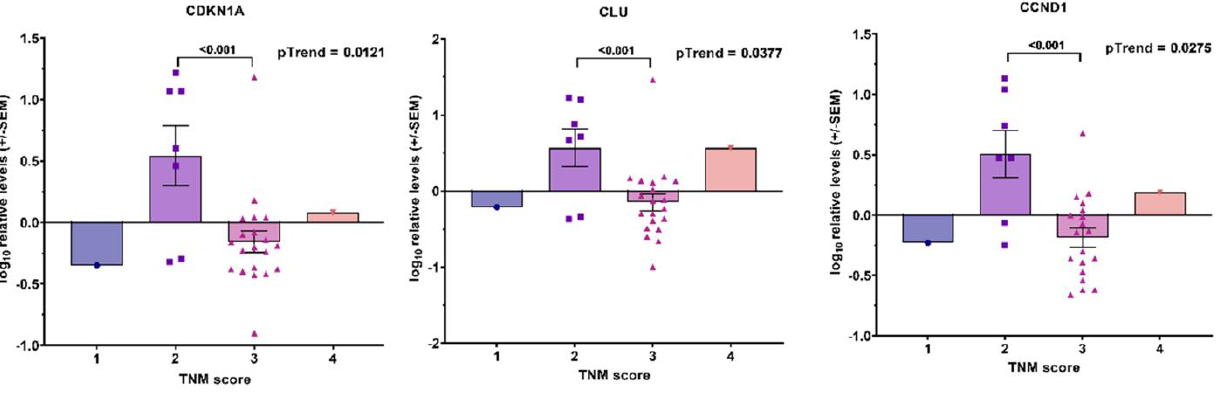
Figure 8. Associations between transcripts’ expression in blood-derived mRNA and TNM score in ADT− cohort. Bar graphs showing − log10 relative expression levels of gene transcripts in different TNM score groups. p values are indicated after linear test for trend following ANOVA or after unpaired t -test between two groups (TNM = 2 and TNM = 3). Moreover, one transcript ( ALAS1 ) was found to correlate with iPSA, two transcripts ( AKT1 and CLU ) were found to correlate with PSA value at PSMA-PET, and three ( CDC25C , CTNNB1, and DDB2 ) with peak uptake (Figure 9).